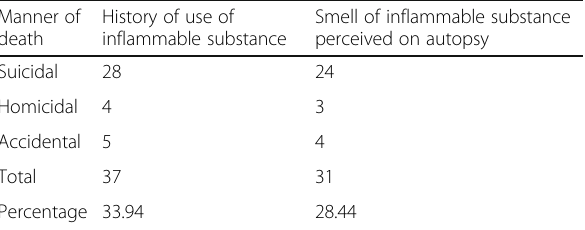
Table 2 Distribution of cases according to inflammable substance Manner of death